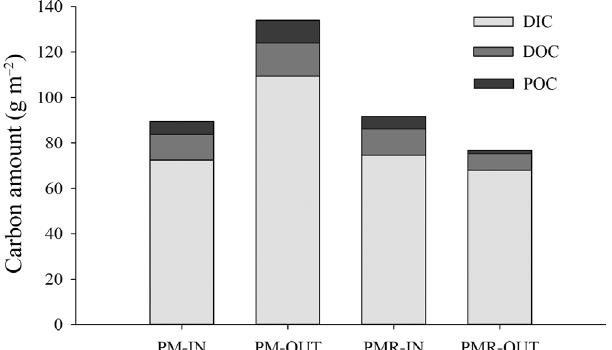
Fig. 1. Amount of dissolved inorganic carbon (DIC), dissolved organic carbon (DOC) and particulate organic carbon (POC) input into/output from the aquaculture systems via water. PM and PMR are defined in Table 1. IN represents input and OUT represents output of carbon in both systems